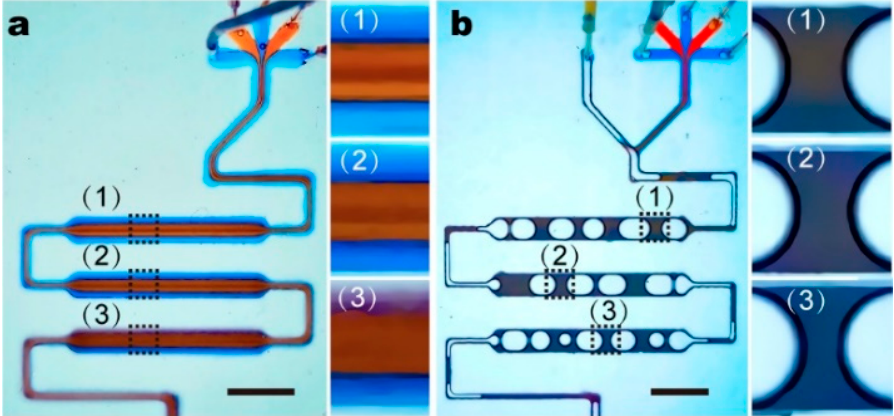
Figure 2. Comparison of mixing e ffi ciency using food dyes between fluidic mixer with ( a ) laminar flow and ( b ) air-bubbles as stirrer. It is demonstrated that with air bubbles, food dyes of di ff erent colors can be quickly mixed. Scale bars denote 5 mm in all figures.